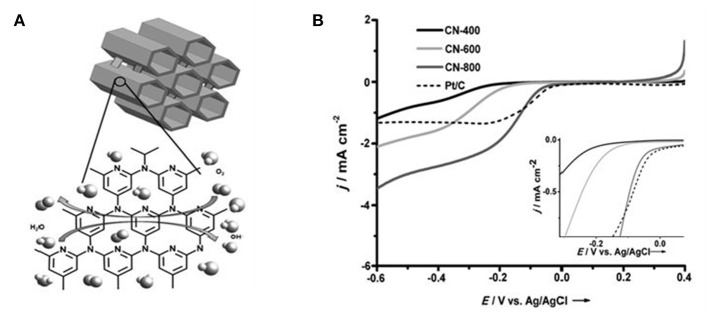
(A) Schematic illustration of N-doped ordered mesoporous graphitic array and N-doped ordered mesoporous carbon synthesis. (B) Polarization curves of MNC catalysts pyrolyzed at different temperatures in 02-saturated 1 M NaOH with a rotation rate of 900 rpm at a scan rate of 5 mV s−1 CE: Pt grid, RE: AglAgCl/3M KCl (inset: magnification of the potential region of the ORR onset). Reprinted from Vinu (2008), with permission from Wiley.